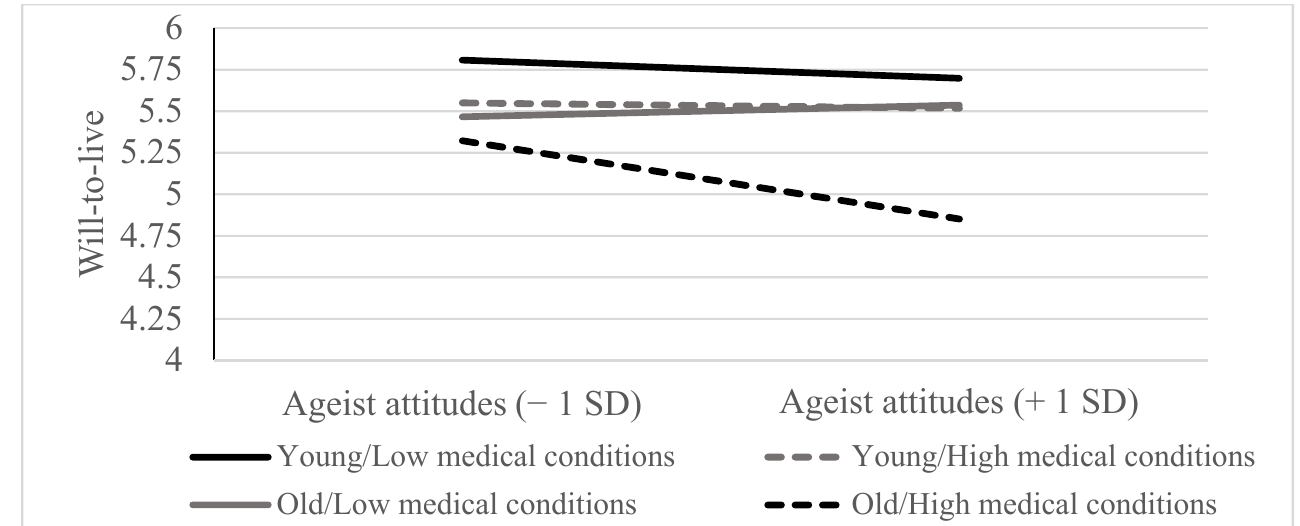
Figure 1. The three-way interaction between ageist attitudes, age group, and medical conditions predicting WTL. These findings highlight the negative implications of ageist attitudes on WTL, partic- ularly for older adults suffering from several medical conditions. Our results are in line with Levy’s stereotype embodiment theory [25], as they may imply that negative attitudes toward older adults which have been internalized over one’s life span may negatively affect one’s drive for survival when one’s medical condition is poor. The results also support existing findings in the literature [16,17], which showed that among younger adults, there were no significant effects of stereotype valence on their